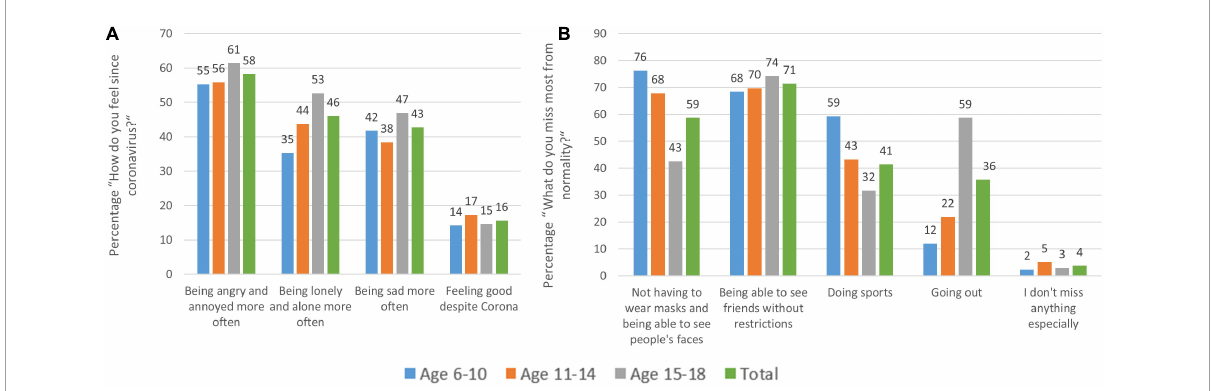
FIGURE5 Distribution of children’s and adolescents’ answers to the question (A) “How do you feel since the coronavirus?” and (B) “What do you miss most from normality?” by age group. (A) Many young participants report being more angry, lonely, or sad than before the coronavirus. What they miss most (B) is not wearing masks, meeting friends, and doing sports as well as going out (in adolescents) with only 4% not missing